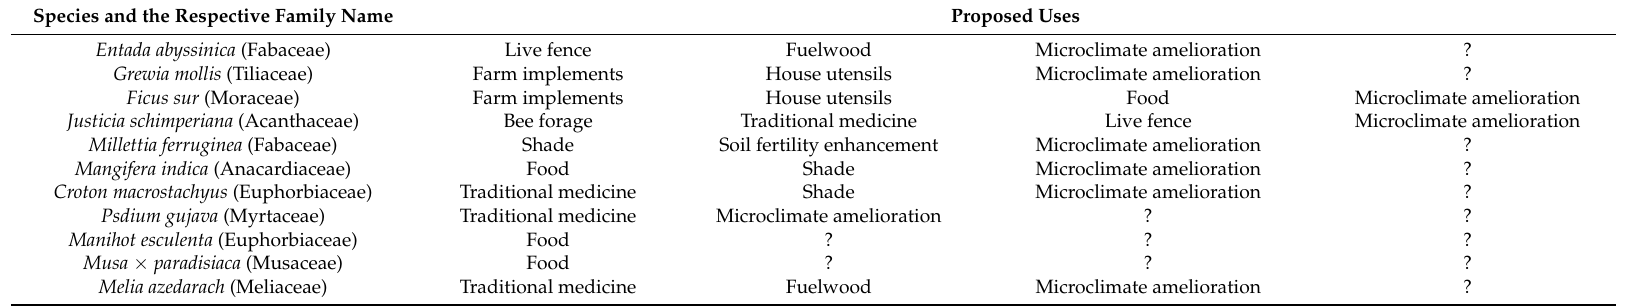
Table A5. Management practices in home gardens and parkland agroforestry systems, as stated by the HHs in Assosa district, western Ethiopia. Woody Species Regeneration